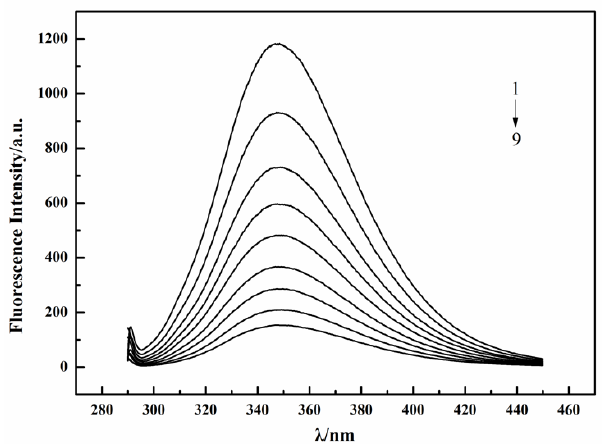
Figure 6. Fluorescence spectra of lysozyme quenched by tannic acid at 333 K. C Lysozyme = 3.6 × 10 − 6 mol/L; C Tannic acid (1–9) = (0, 1.8, 3.6, 5.4, 7.2, 9.0, 10.8, 14.4, 18.0) × 10 −6 mol/L.